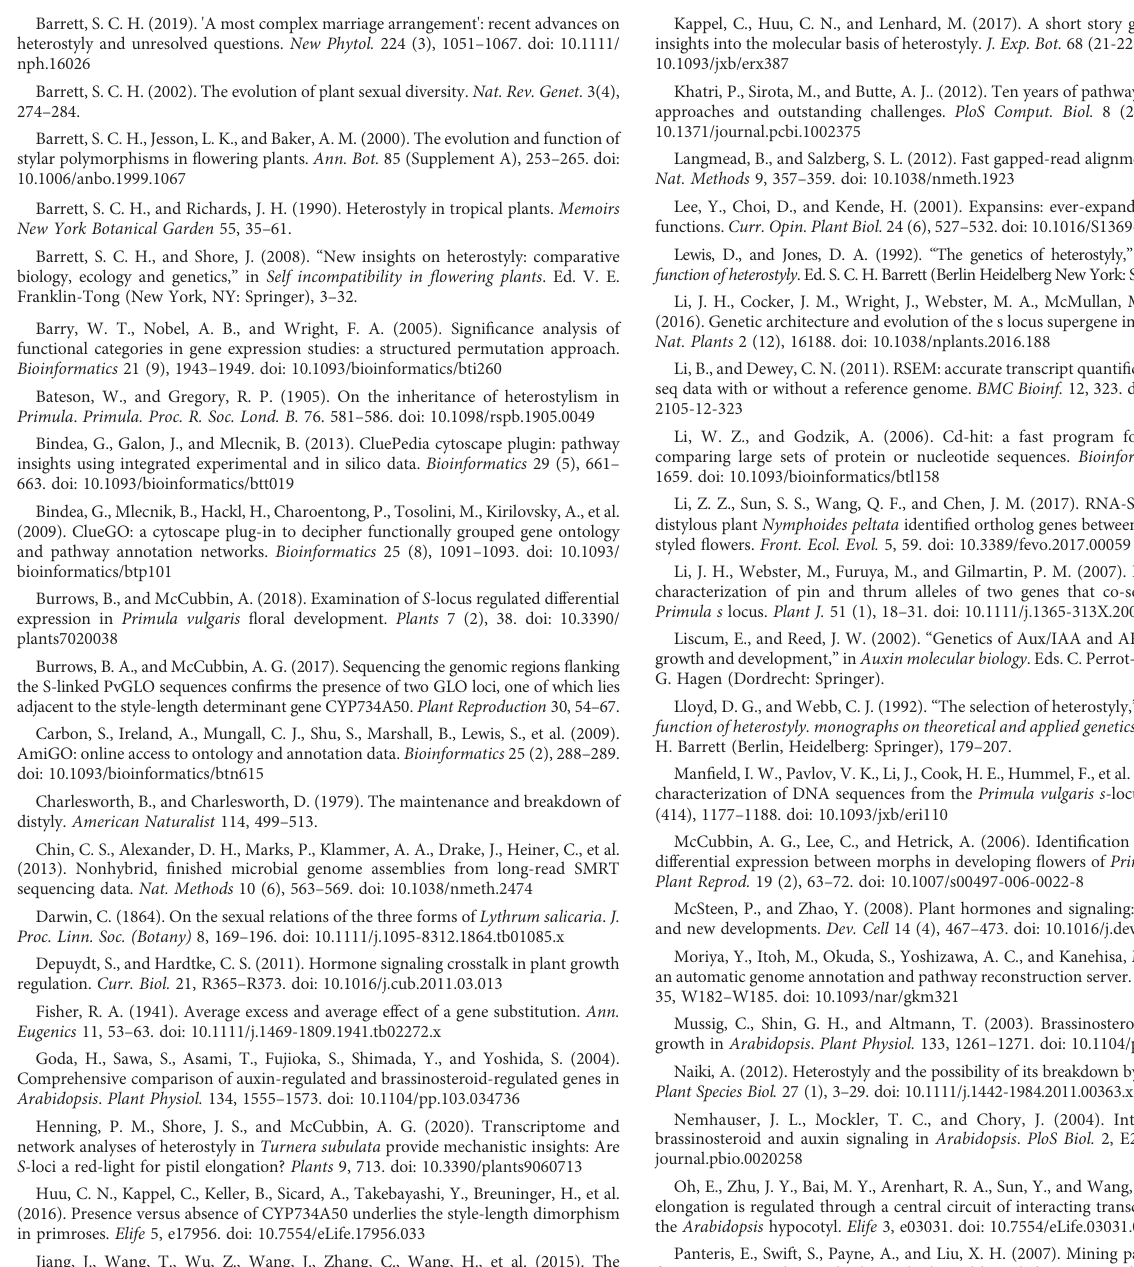
SUPPLEMENTARY FIGURE 4 Module-trait relationships showing co-expressed gene modules correlated with the style length in WGCNA analysis. Each color cell contains the corresponding correlation and p -value (in brackets). SUPPLEMENTARY FIGURE 5 PPI network constructed from the DEGs between L- and S-morph styles of G uettarda speciosa